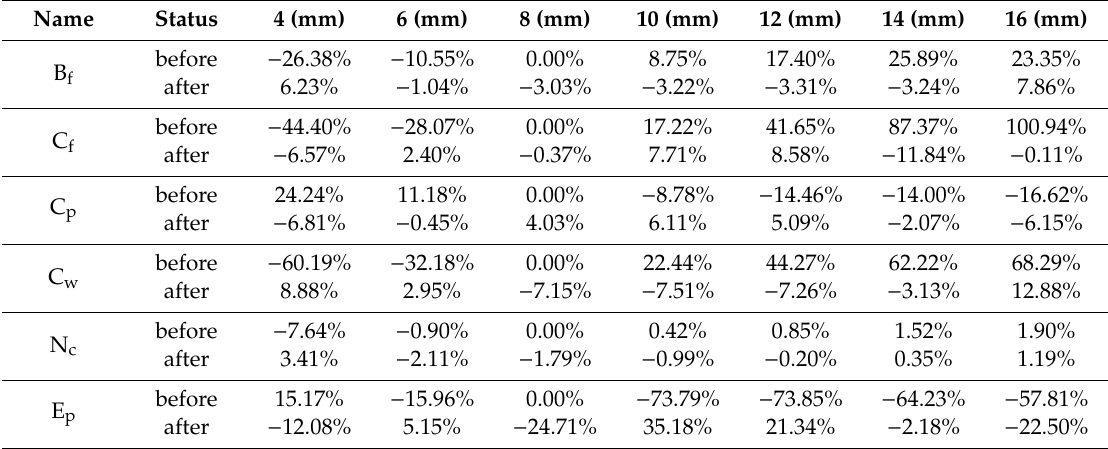
Table 7. The correction of similarity error by fitting